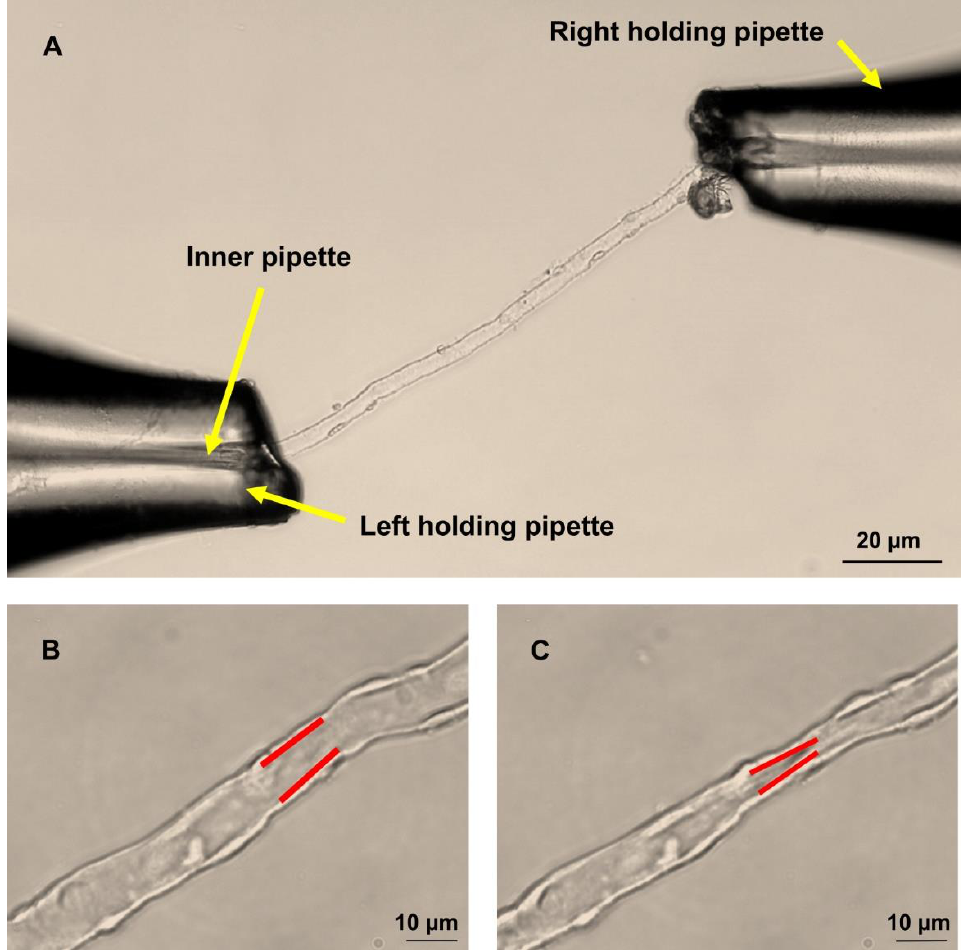
Figure 7. ( A ) Microperfusion of rat DVR using holding and perfusion pipettes. ( B ) Resting and ( C ) constricted DVR with the site of constriction marked in red.